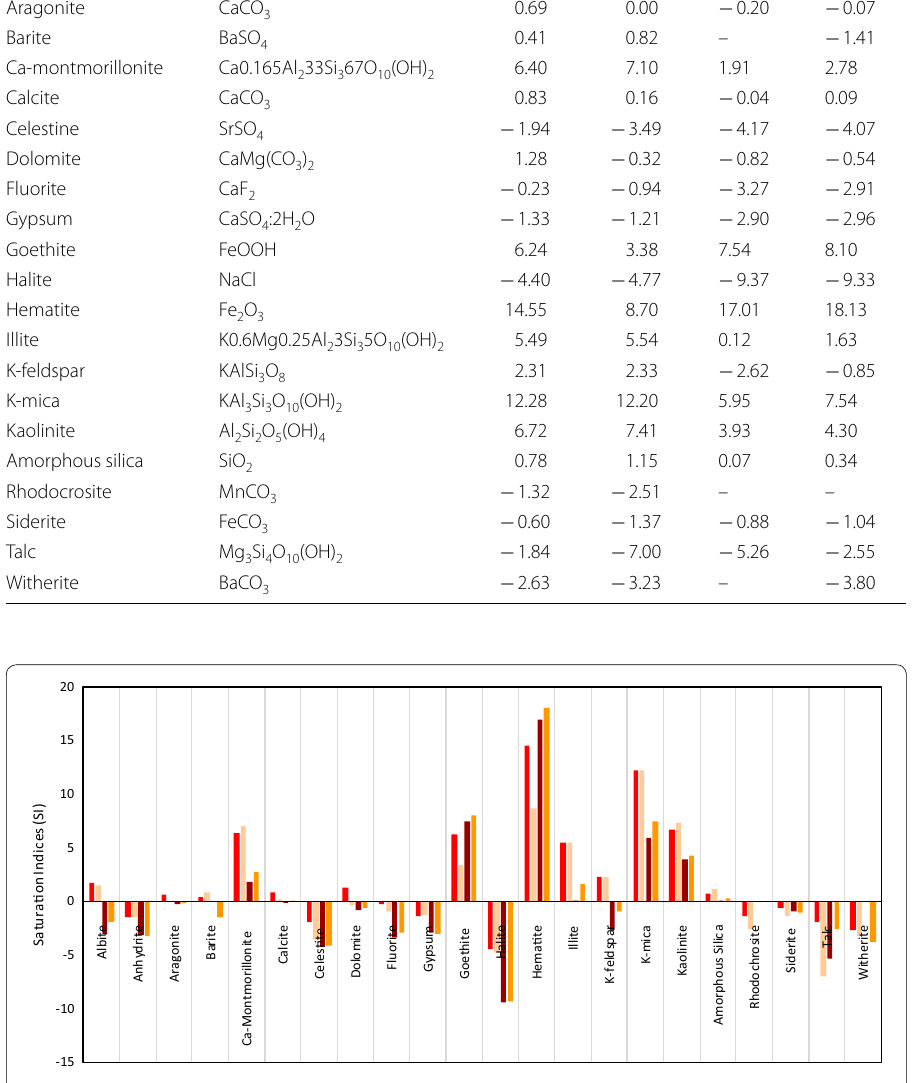
augite, hornblende, and quartz, while secondary minerals are calcite, quartz, and chlorite. The SI was calculated for minerals selected from the limestone, sandstone, gypsum lenses, and opaque minerals forming sedimentary units using the AquaChem chemical equilibrium software. Negative SI values in Table 4 indicate an undersatu- rated solution, and positive values indicate an oversaturated solution. SI values that are meaningless (e.g., 40) were ignored. When the SI values were examined, all hot − and cold waters were not saturated with respect to sulfate minerals such as anhydrite